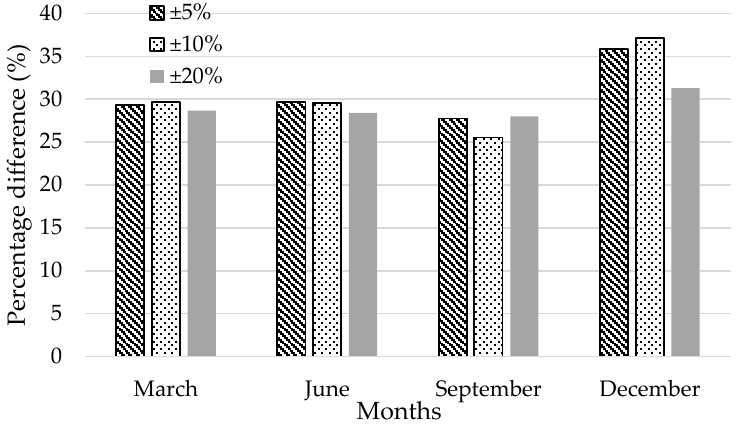
Figure 11. Differences in the PV curtailment standard deviation of the conventional method based on the proposed